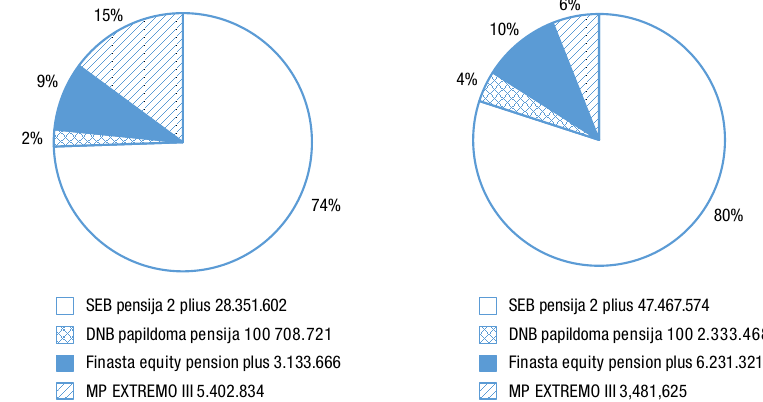
Fig. 9. The structure of equity 3 rd pillar PF in 2008 on the left side and in 2012 on the right side Source : created by authors according to annual reports of PF.